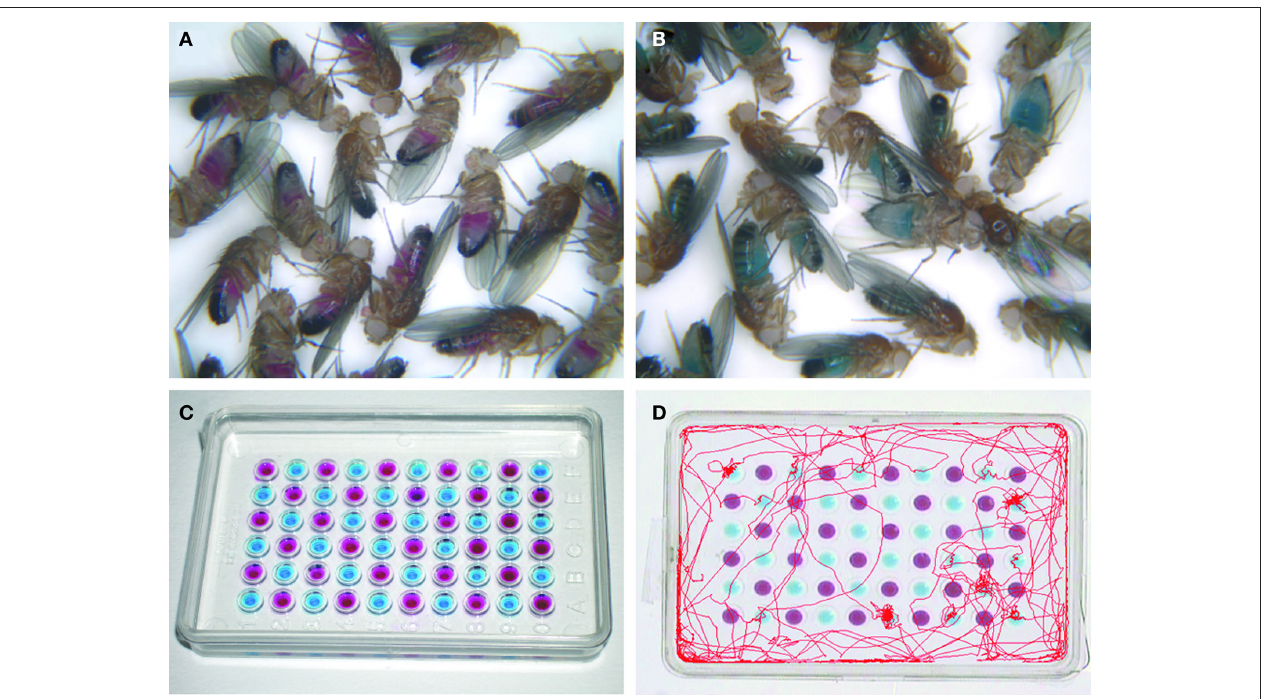
analysis simultaneously monitoring the locomotor traces of three individual flies in the choice of 100 mM sucrose + 1% agar solution (marked with a blue dye) and a plain 1% agar solution (marked with a red dye). The traces show that more frequent visits or stays were made on wells containing 100 mM sucrose than on wells containing plain water. The video analysis was provided courtesy of Dr. M. Koganezawa).